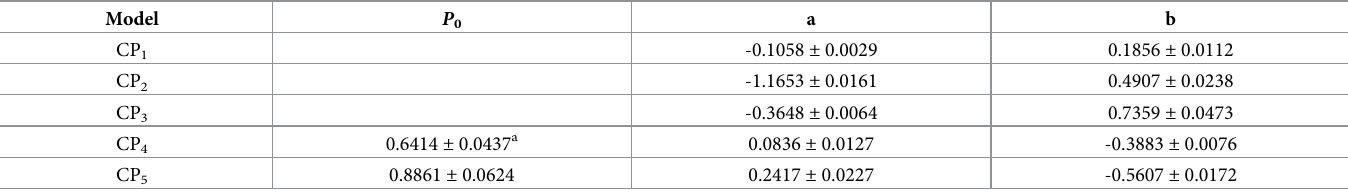
Table 4. Regression parameters for each model based on the simulation